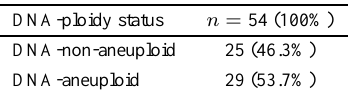
Prevalence of DNA-aneuploidy in cells in cytologically equivocal effusions DNA-ploidy